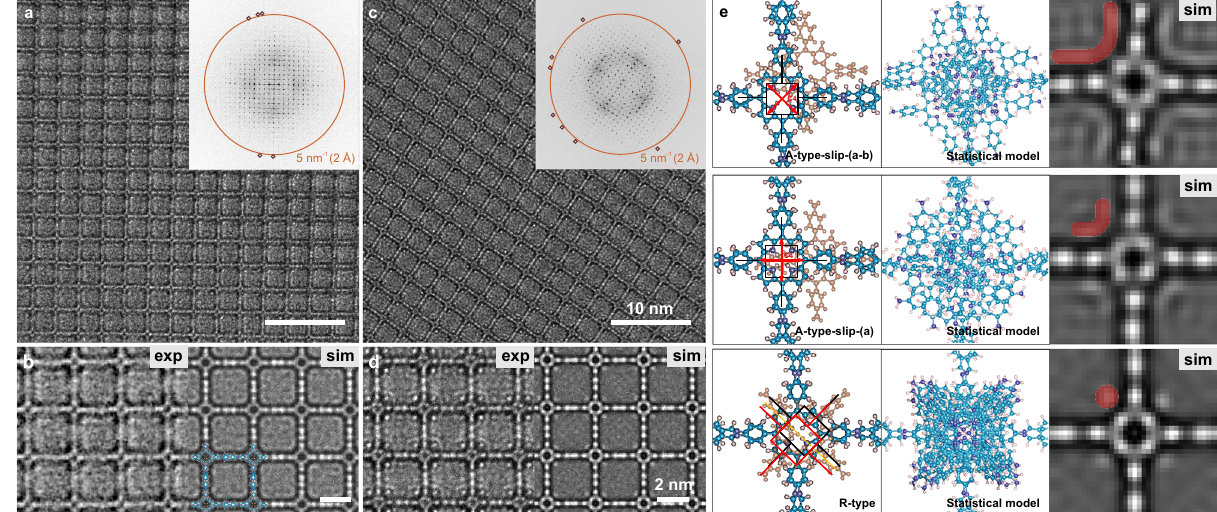
Fig. 3 AC-HRTEM imaging of 2D-PI-BPDA and image simulations. a , c Unprocessed AC-HRTEM images of 2D-PI-BPDA without and with TAPP interstitials, respectively. Scale bar: 10 nm. Insets: FFT patterns of ( a ) and ( c ). The orange circle marks the spatial frequency of 5 nm − 1 (i.e., 2 Å). The maroon circles mark the re fl ections beyond 5 nm − 1 . b , d Left: magni fi ed images from ( a ) and ( c ), respectively. The images have been denoised using Wiener fi ltering. Right: simulated images of 2D-PI-BPDA without molecular interstitials and with R-type TAPP interstitials. Simulation conditions: thickness 15 nm, defocus 50 nm. Scale bar: 2 nm. e Plausible stacking modes of TAPP interstitials derived by DFTB calculations. The statistical models and corresponding simulated images are shown in the middle and right column, respectively. The emerging contrast due to the interstitial TAPP molecules is marked in red on the simulated images.